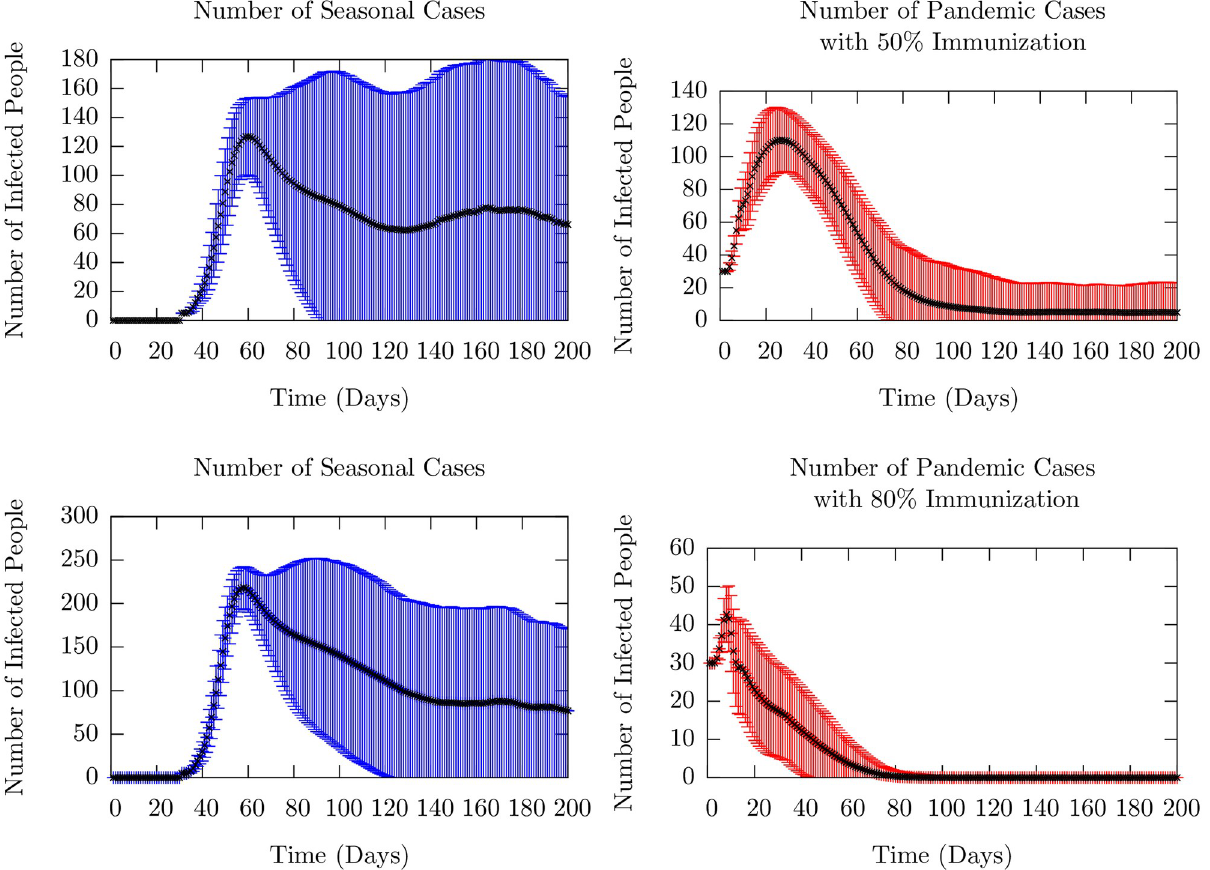
Fig 12. Mean infected (sum of exposed and infectious) agent number as a function of time. The black dots represent ensemble averages over 10,000 runs, and the colored bars represent the standard deviation. Individual runs which contributed to these averages are presented in S9 Fig. The left column (blue) shows the number of seasonal cases, while the right column (red) shows the number of pandemic cases. For the top row, 50% of the population was inoculated against the pandemic strain as detailed in the text, whereas in the bottom row, 80% of the population was inoculated. We see that the higher level of inoculation effectively prevents even the first peak of infection. However, this prevention is compensated by a large wave of infection in the seasonal strain; the number of peak cases is twice that of the lower inoculation rate. This feature is examined in the main text.